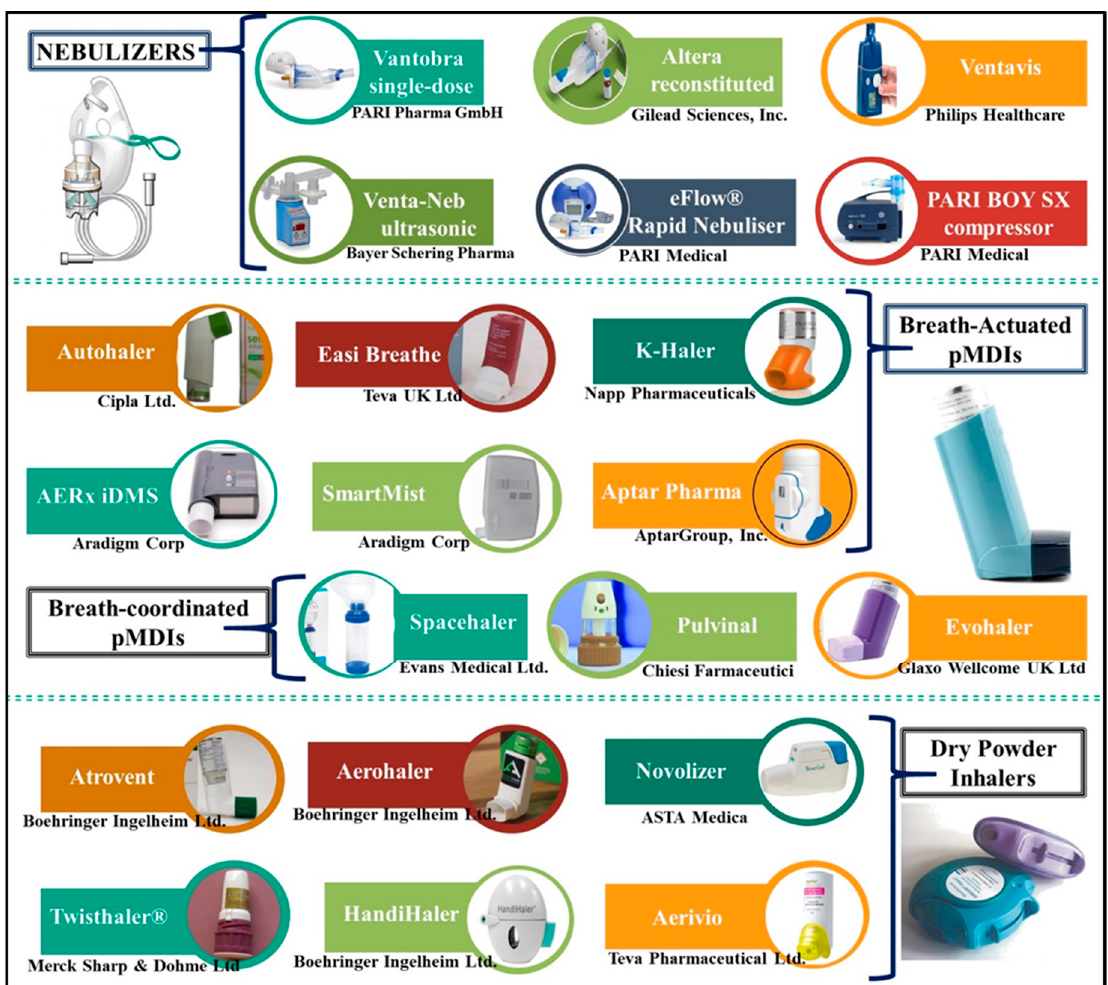
Figure 4. Representative example of devices (brand names) for inhalation drug delivery.